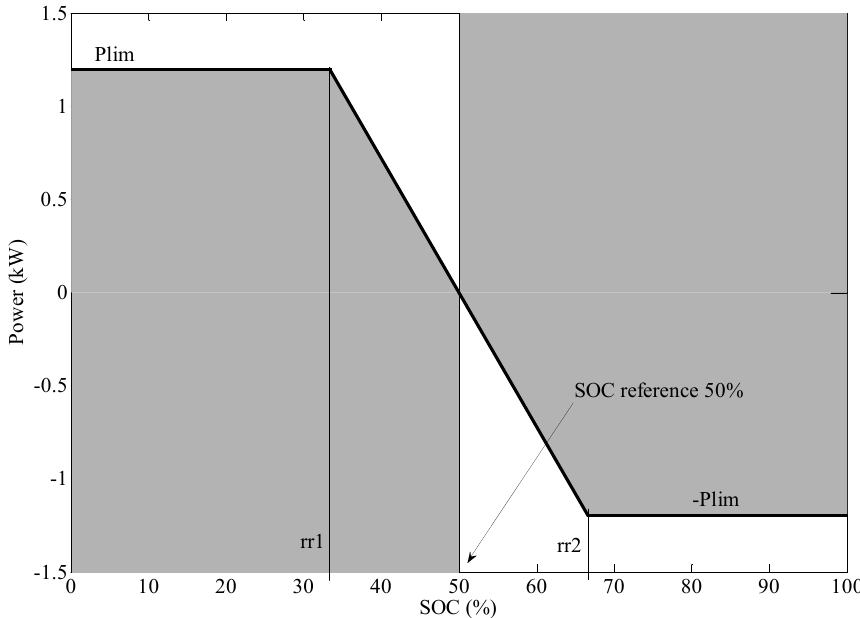
Figure 12. P value in black thick line and control zones colored in 2